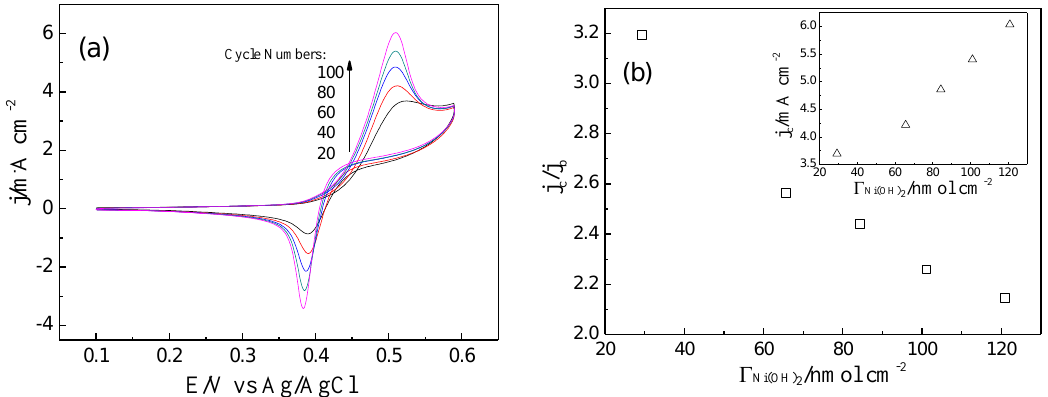
Figure 2. ( a ) Cyclic voltammograms of Ni in 1 mol L − 1 KOH / 20 mmol L − 1 benzyl alcohol after submitting to 1 mol L − 1 KOH upon di ff erent numbers of potential cycling, ( b ) relative anodic-peak current density and anodic-peak current density (inset) as a function of nickel hydroxide loadings for benzyl alcohol electrooxidation.